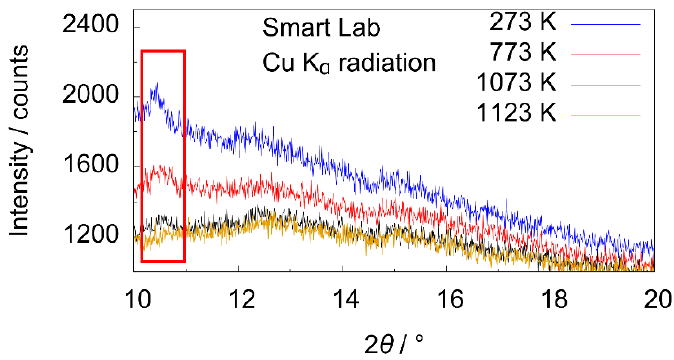
Figure 11. Comparison of the X-ray diffraction data of the first batch of Ba 2 In 1.8 Cr 0.2 O 5.3 (H 2 O) x at low angles. Superstructure reflection at about 2 θ = 10.5 ◦ . The measurement was carried out in a flow of 20 sccm N 2 ( p = 0.15 MPa, p (O 2 ) < 5 ppm, p (H 2 O) < 5 ppm).